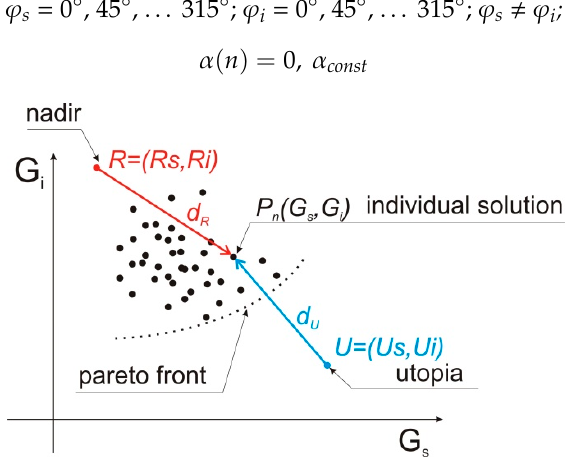
Figure 9. The definition of d R and d U in the objective function components space.